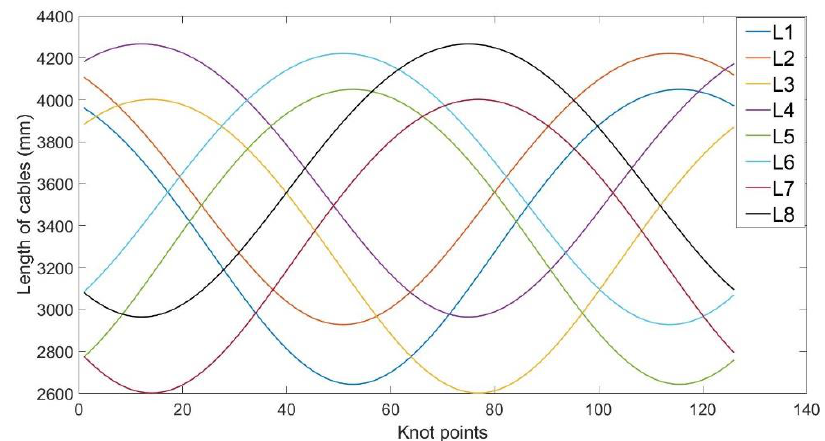
Figure 8. Length of the 8 cables for circle interpolation (r = 0.8 m trajectory).